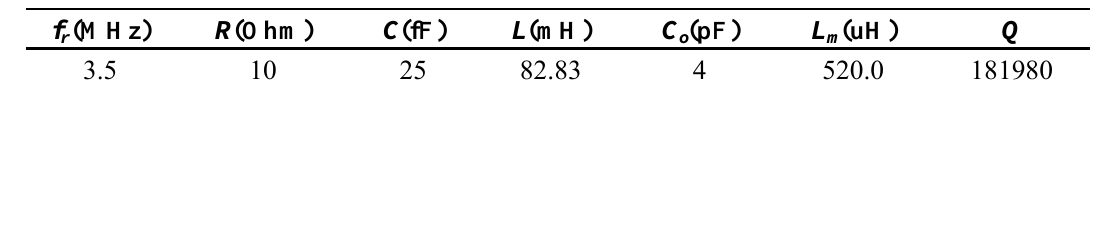
Figure 2. Frequency pulling for fn1 ( L in relation to the change of L